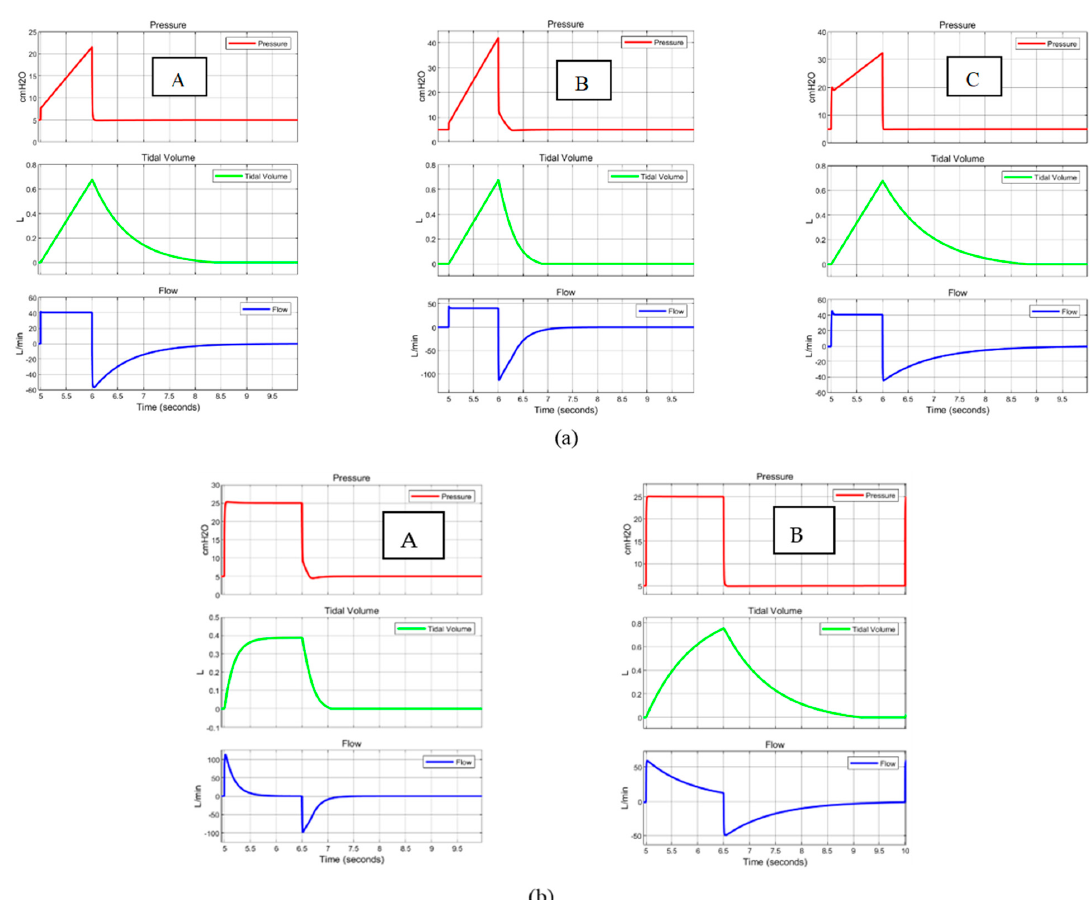
Figure A5. Case 3. Simulation results concerning the resistance and compliance changes in terms of pressure, tidal volume, and inspiratory flow: ( a ) VC-CMV mode ([A] C RS = 0.05 L/cmH 2 O, R insp = 5 cmH 2 O/L/s, R exp = 15 cmH 2 O/L/s; [B] C RS = 0.02 L/cmH 2 O, R insp = 5 cmH 2 O/L/s, R exp = 15 cmH 2 O/L/s; [C] C RS = 0.05 L/cmH 2 O, R insp/exp = 20 cmH 2 O/L/s); ( b ) PC-CMV mode ([A] C RS = 0.02 L/cmH 2 O, R insp/exp = 10 cmH 2 O/L/s; [B] C RS = 0.05 L/cmH 2 O, R insp/exp = 20 cmH 2